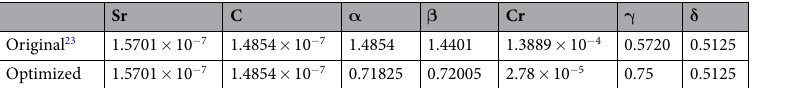
Table 3. Values of the model parameters used for the numerical prediction of shear-induced platelet activation